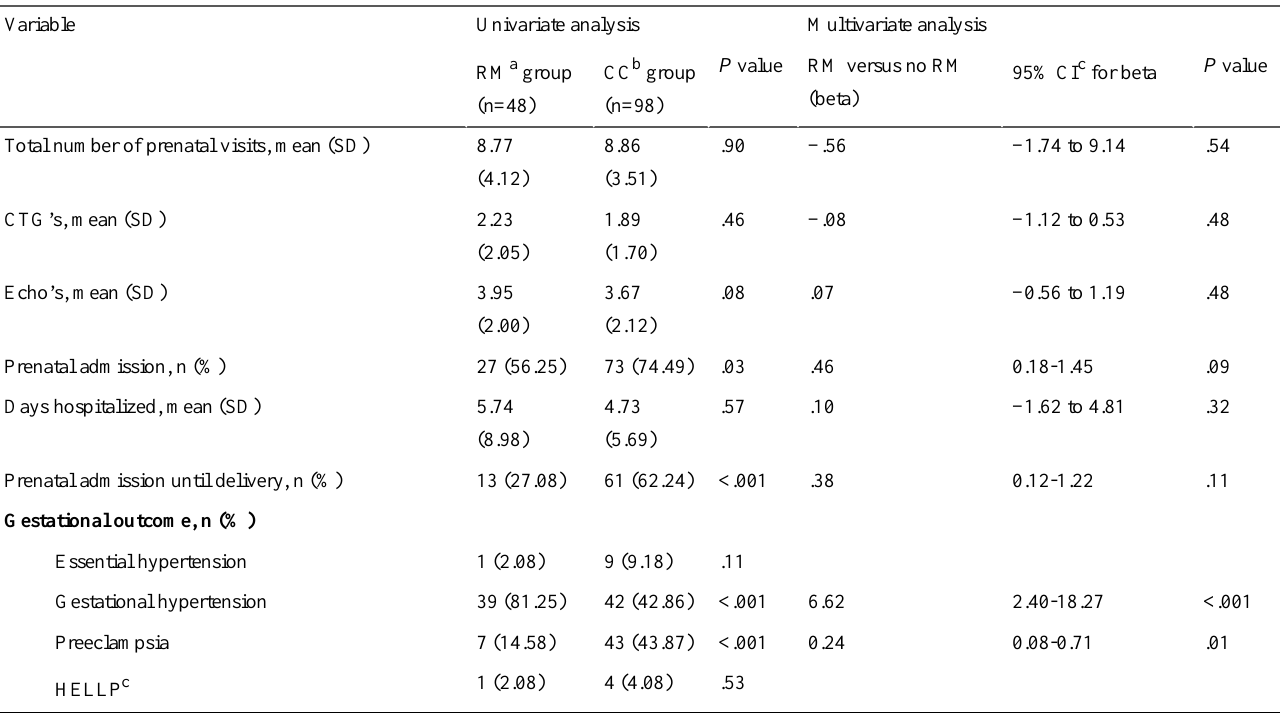
Table 2. Prenatal follow-up.